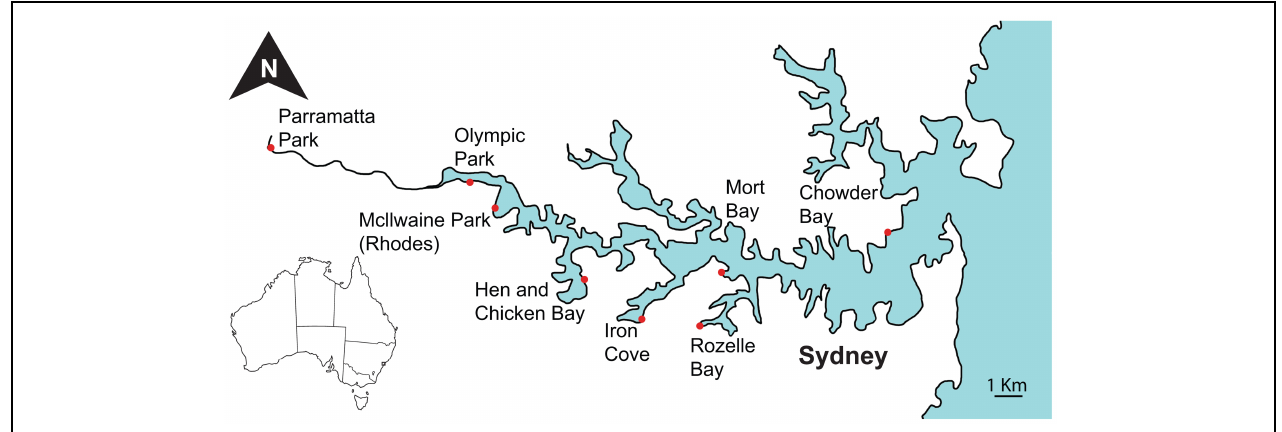
FIGURE 1 | Map of sampling locations along the Parramatta River and within Sydney